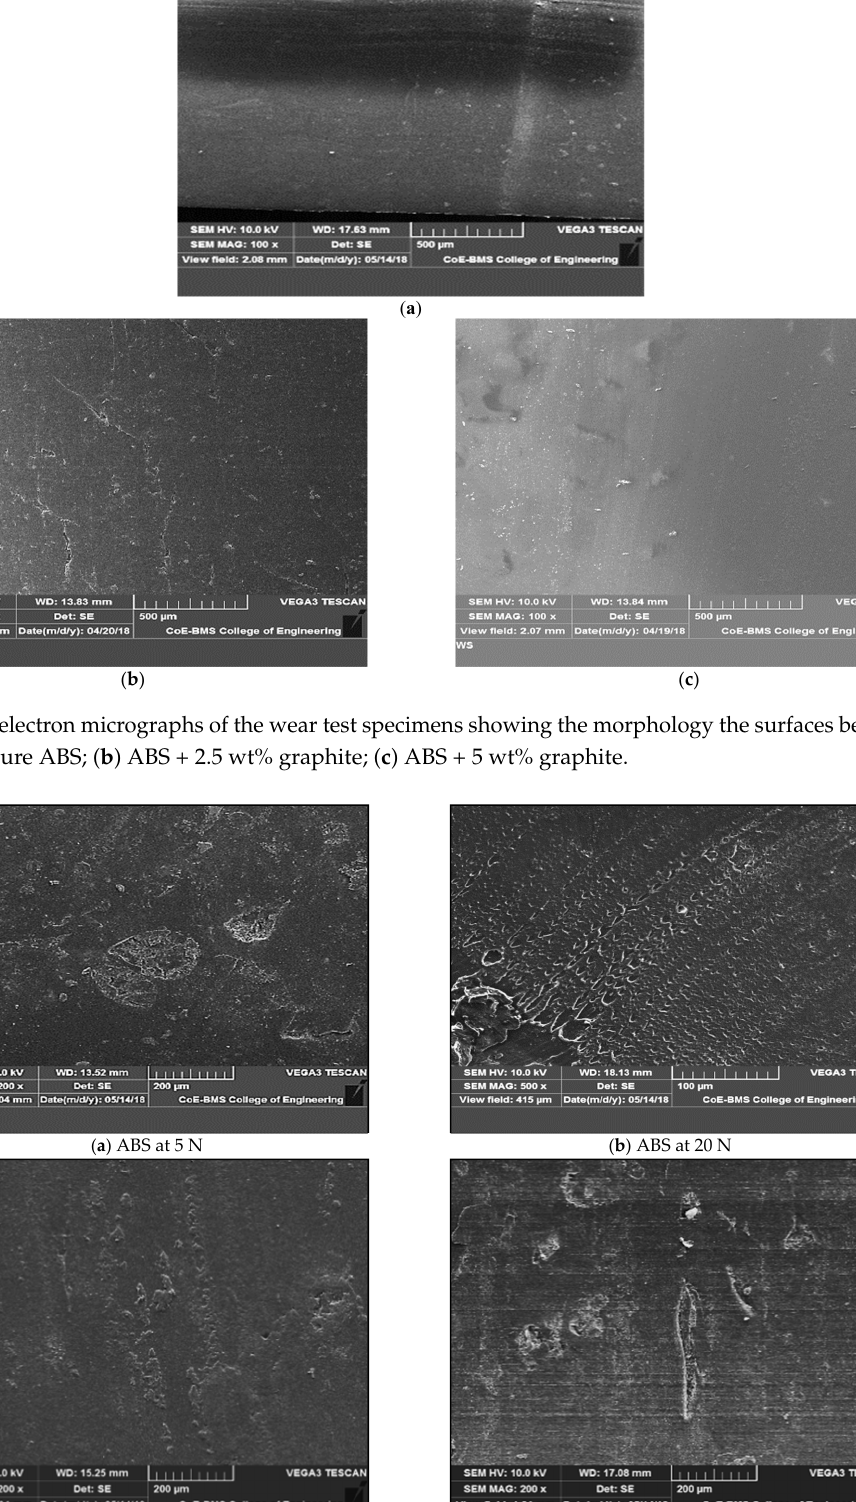
Figure 8. Schematic representation of the wear mechanism involved in the graphite filled ABS samples developed by FDM process.